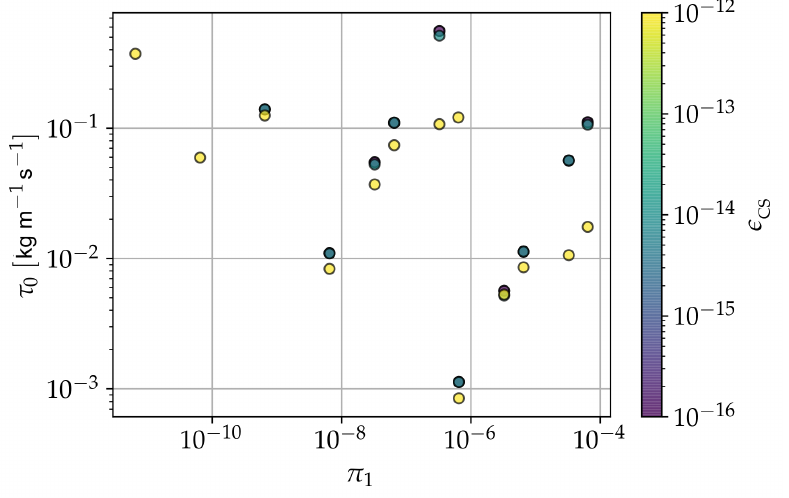
Figure 29. Values of yield shear stress τ 0 obtained in the pipe flow numerical experiments for different values of π 1 and (cid:101) CS